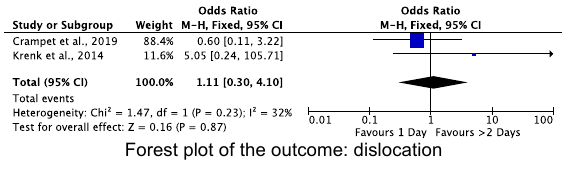
Forest plot of the outcome: dislocation